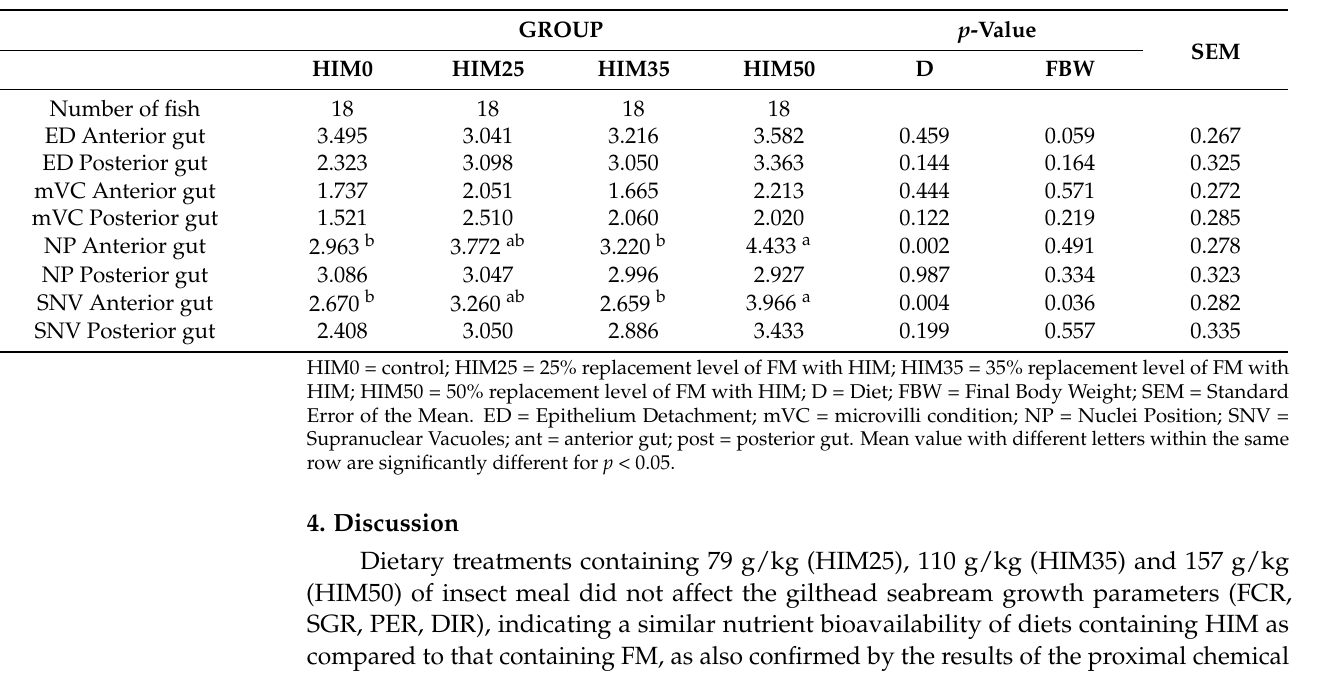
Table 6. Semi-quantitative scoring analysis (score 0–5) of morphological changes of the intestine of gilthead seabream fed the experimental diets. GROUP p -Value HIM0 HIM25 HIM35 HIM50 D